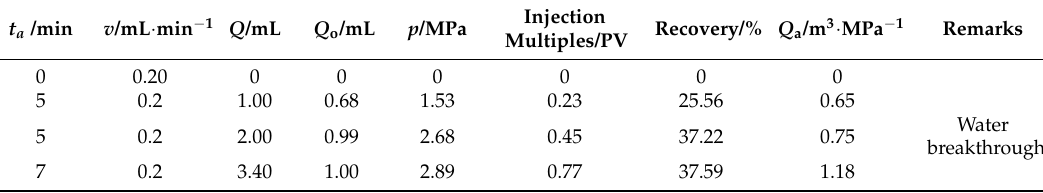
Table 11. Second group of water flooding experiment